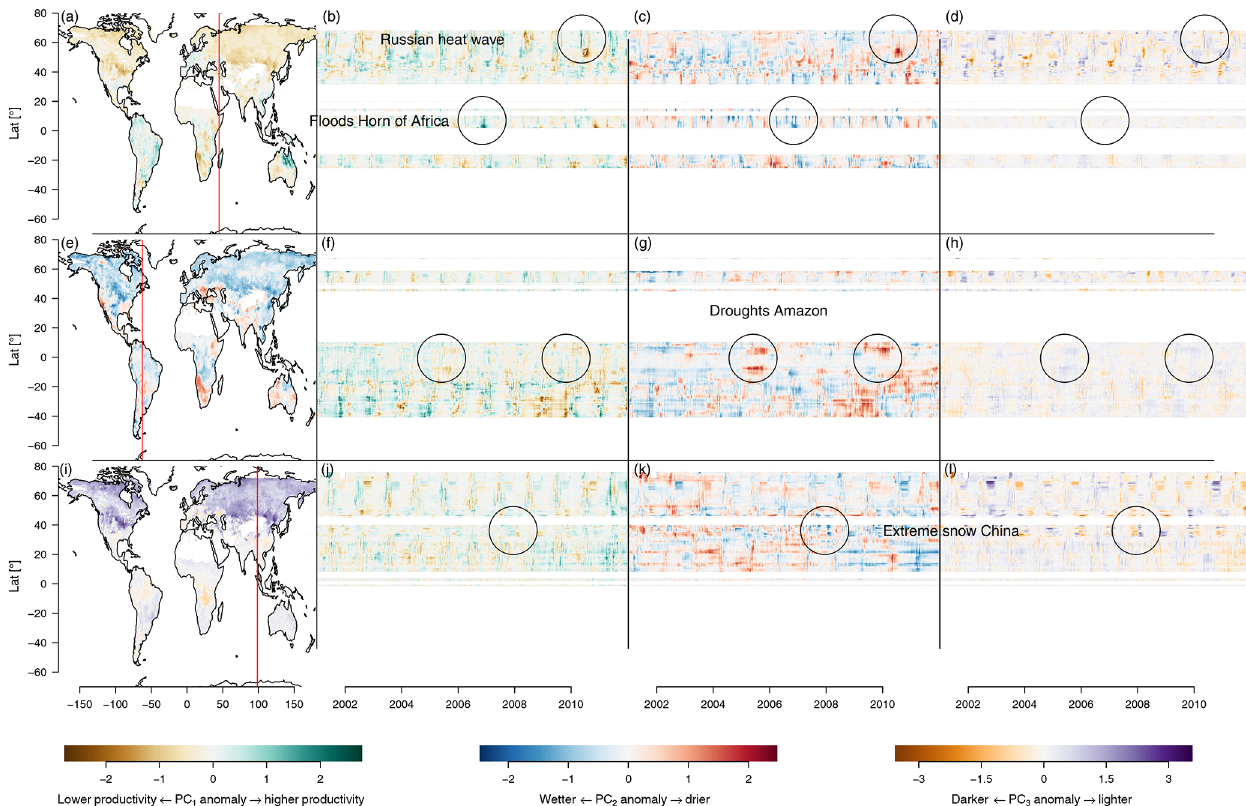
Figure 8. Anomalies of the first three principal components. The brown–green contrast shows the anomalies on PC 1 , a relative low pro- ductivity or greening, respectively. The blue–red contrast shows the anomalies on PC 2 , a relative wetness or dryness, respectively. The brown–purple contrast shows the anomaly on PC 3 , a relative deviation in albedo. Panels (a) , (e) , and (i) are maps showing the anomalies of PC 1 –PC 3 , respectively, on 1 January 2001. Panels (b) , (c) , and (d) show longitudinal cuts of PC 1 –PC 3 , respectively, at the red vertical line in (a) . The effects of the floods on the Horn of Africa (2006) and the Russian heat wave (2010) are highlighted by circles. Panels (f) , (g) , and (h) show longitudinal cuts of PC 1 –PC 3 , respectively, at the red vertical line in (e) . Strong droughts in the Amazon during 2005 and 2010 can be observed as large red spots on the fringes of the Amazon basin (highlighted by circles). Panels (j) , (k) , and (l) show longitudinal cuts of PC 1 –PC 3 , respectively, at the red vertical line in (i) . A strong snowfall event affecting central and southern China is marked as